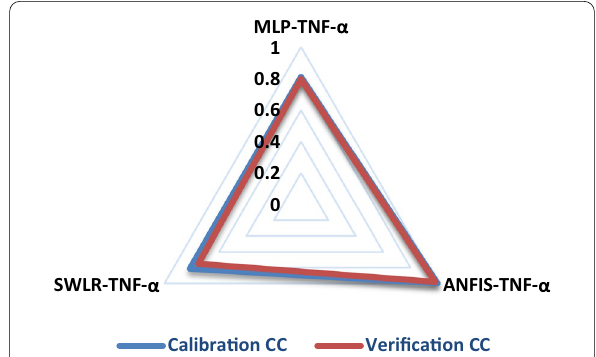
Fig. 6 Comparative performance of SWLR, ANFIS and MLP in modelling TNF-α inflammatory biomarker using the correlation co-efficient in both the calibration and verification stages